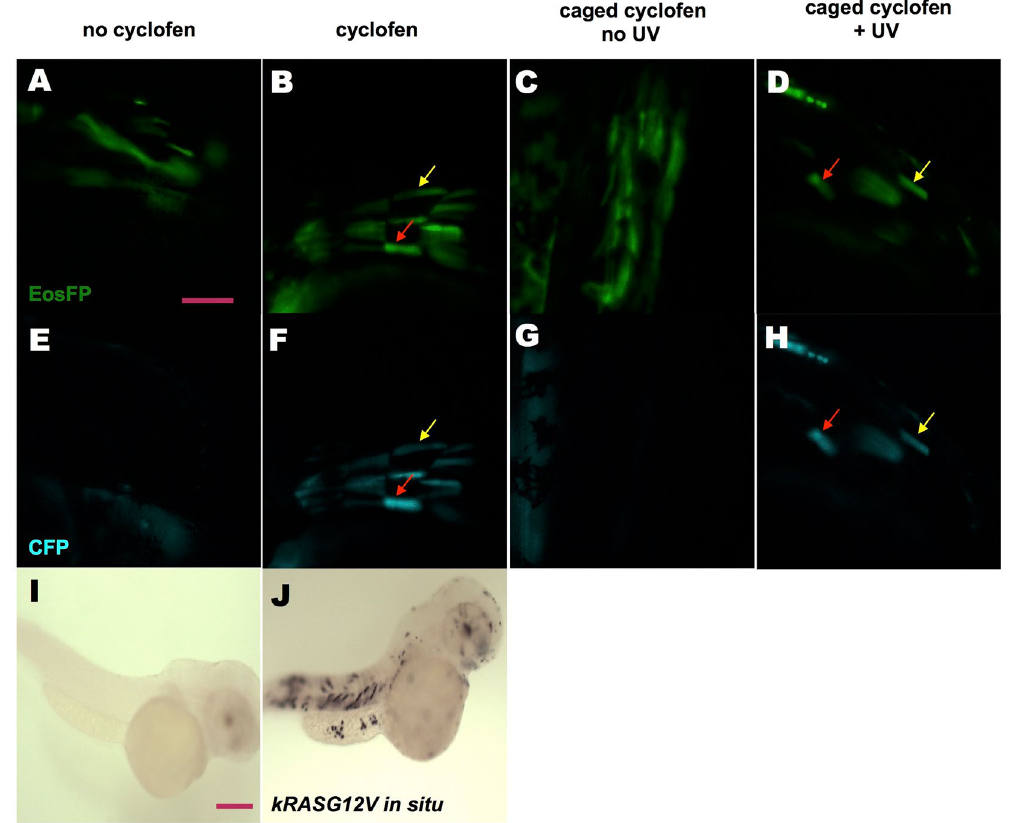
Figure 2. KRASG12V induction by incubation in cyclofen or photo-activation of caged cyclofen. ( A , E ) Injecting UAS:kRASG12V-T2A-CFP; ubi:Eos plasmid into Tg(ubi:Gal4-ERT2) embryos resulted in a mosaic expression of EosFP protein, but (in absence of free cyclofen) no expression of CFP. ( B , F ) Embryos treated with 2 μ M cyclofen at 32hpf display expression of CFP co-localized with EosFP expression (denoted by arrows). ( C , G ) Incubation of caged cyclofen (with no UV) did not activate CFP expression while ( D , H ) 2 min UV uncaging effectively activated the expression of CFP 12 hours later (denoted by arrows). The induction of kRASG12V by cyclofen was confirmed by kRASG12V mRNA in situ hybridization. Human kRASG12V mRNA was transcribed only in the embryo incubated in cyclofen ( J ), but not in the control embryo ( I ). Scale bar: 200 μ